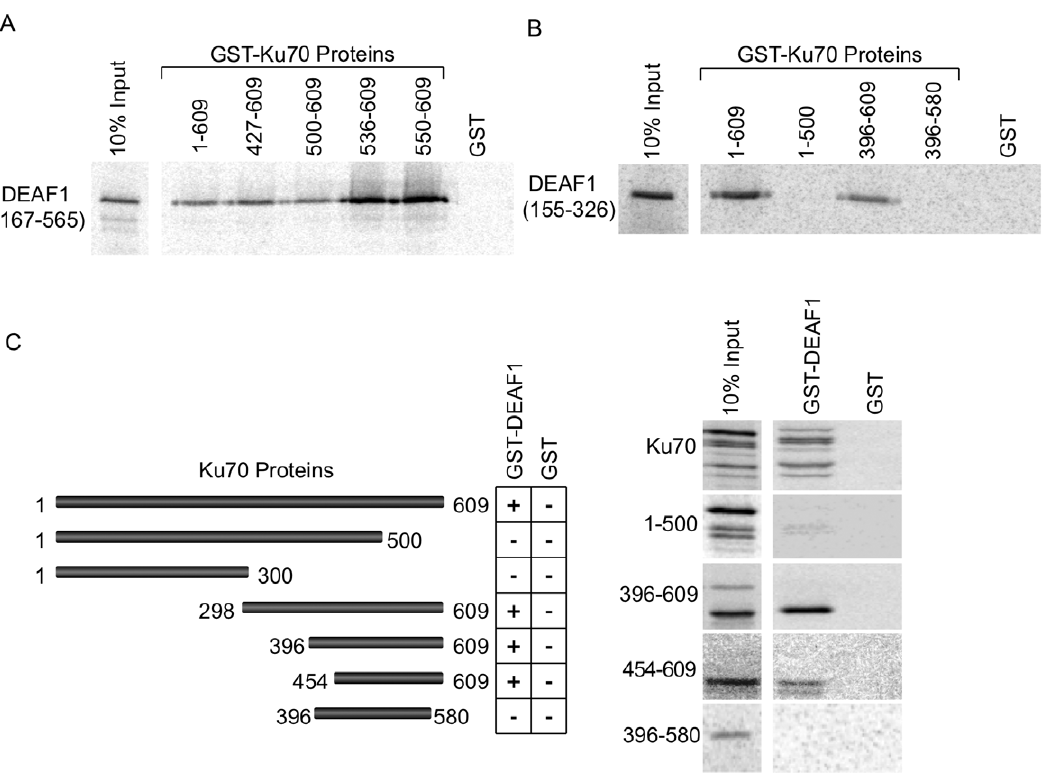
Figure 3. DEAF1 interacts with the C-terminal end of Ku70. ( A and B ) GST-Ku70 fusion proteins with N-terminal and/or C-terminal deletions of Ku70 were used in pull-downs with in vitro translated [ 35 S]methionine-labeled DEAF1 (167–565) shown in (A) or DEAF1 (155–326) shown in (B). The results are representative of two independent experiments. ( C ) GST tags were reversed relative to (A) and (B) and GST-DEAF1 was used to pull-down in vitro translated Ku70 peptides (right panel). A schematic representation of all the Ku70 translated proteins tested is shown in the left panel. Results are summarized as a positive interaction ( + ) or no interaction ( 2 ).